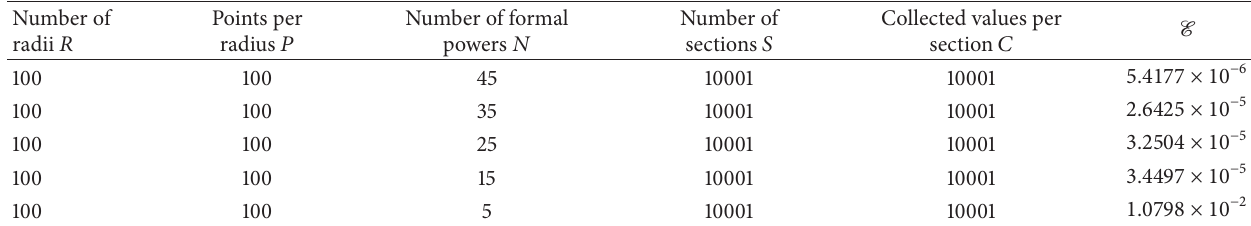
Table 8: Relation between the error E and the number of formal powers 𝑁 , when 𝜎 = 𝑒 𝑥𝑦 . Number of radii